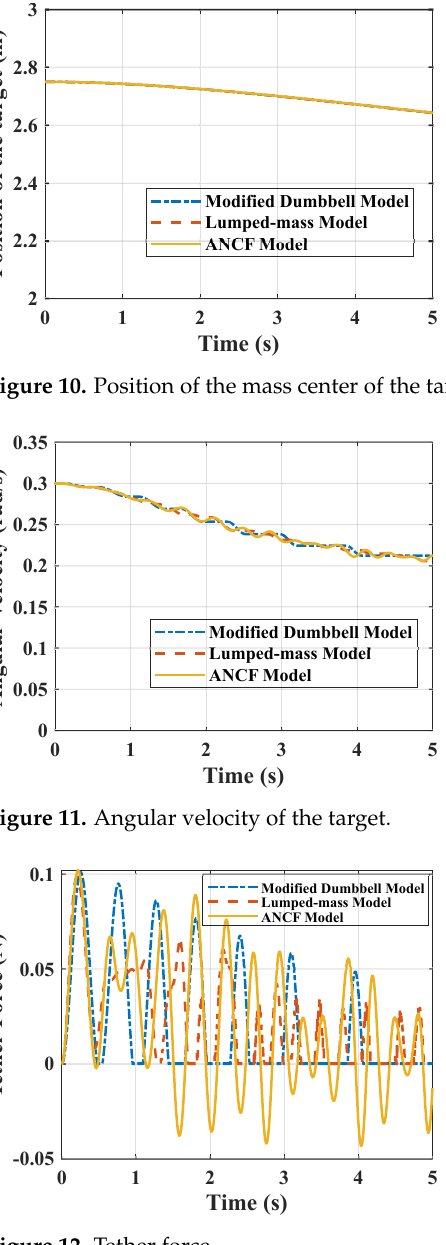
Figure 12. Tether